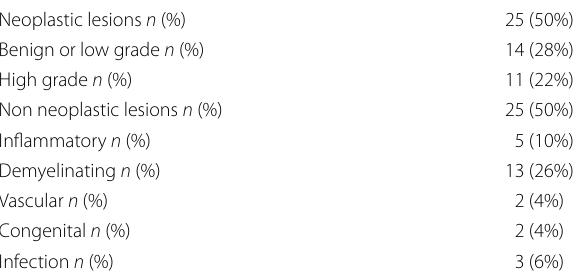
Table 2 Classification of lesions in relation to its nature Neoplastic lesions n (%) Benign or low grade n